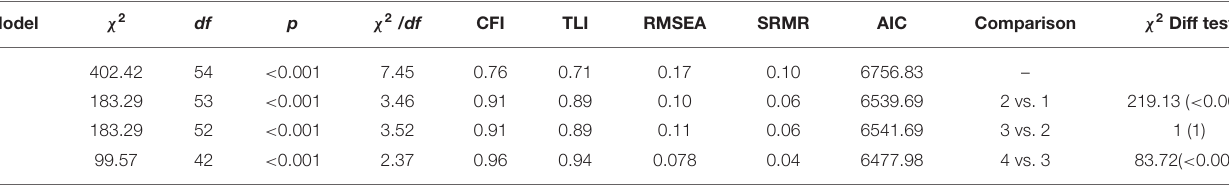
TABLE 2 | Confirmatory factor analyses in Sample B. Model